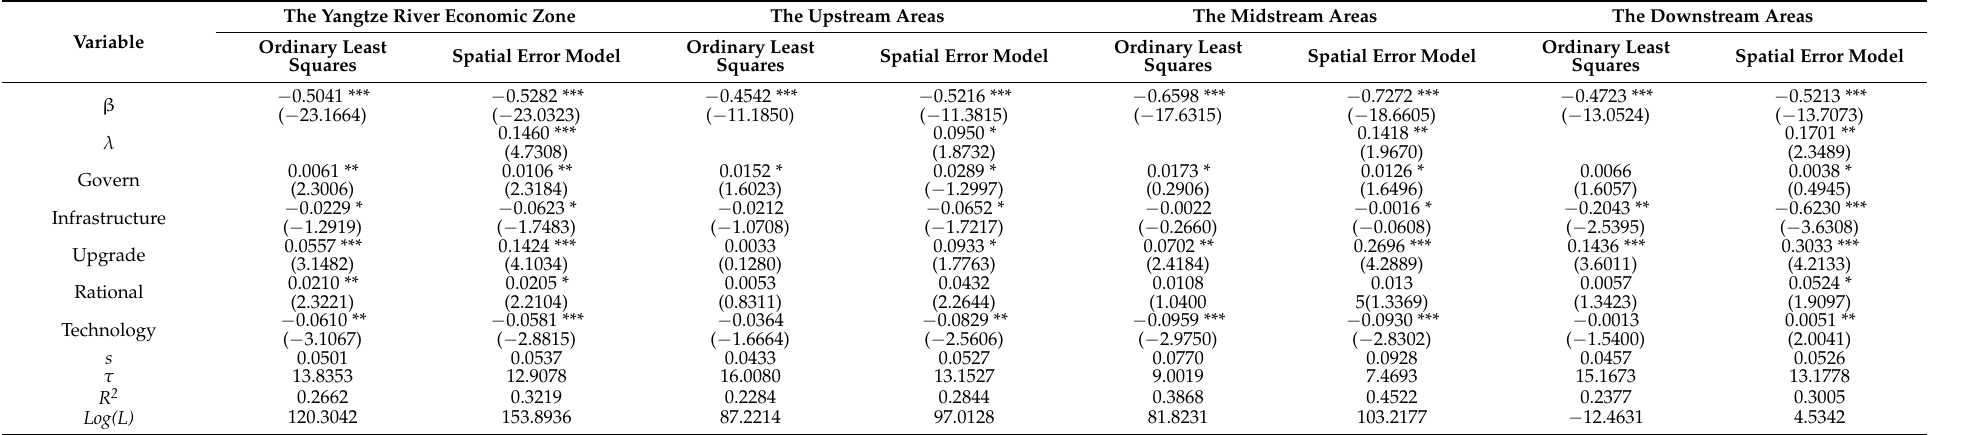
Table 5. Conditional β -convergence estimation